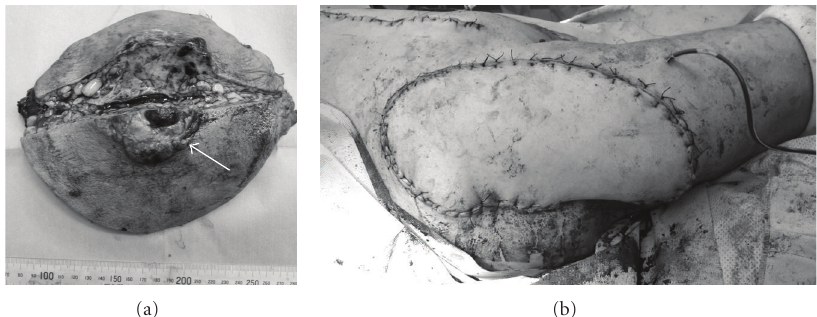
Figure 6: (a) Macroscopic findings of the resected tumor with adjacent soft tissues. Note that the specimen was longitudinally dissected across the tumor (white arrow). (b) Post-operative findings repaired with a musculocutaneous flap of rectus